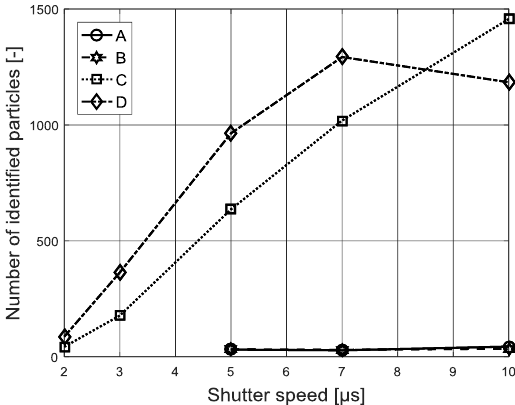
Fig. 9. Number of identified particles – effect of shutter speed.